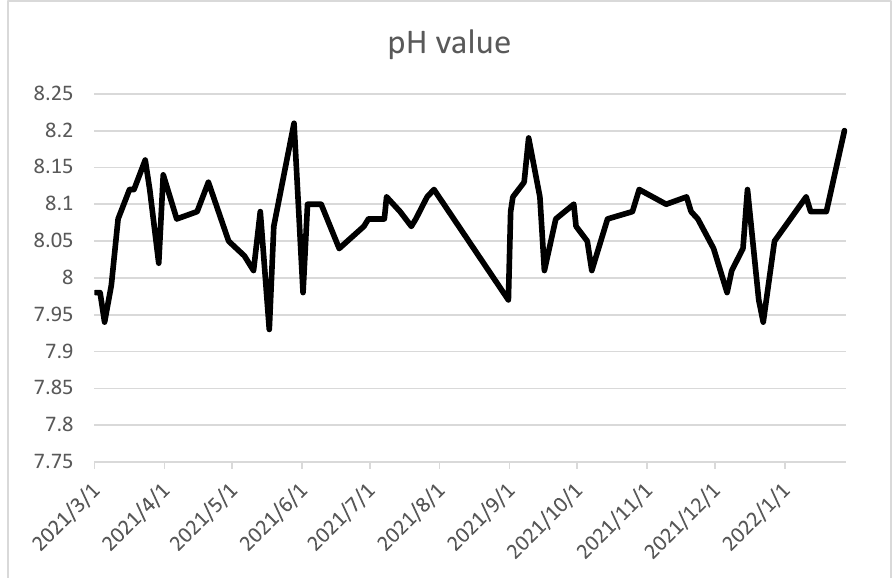
Figure 6. pH-meter results from the South Basin Barcelona port water. Source: The authors.